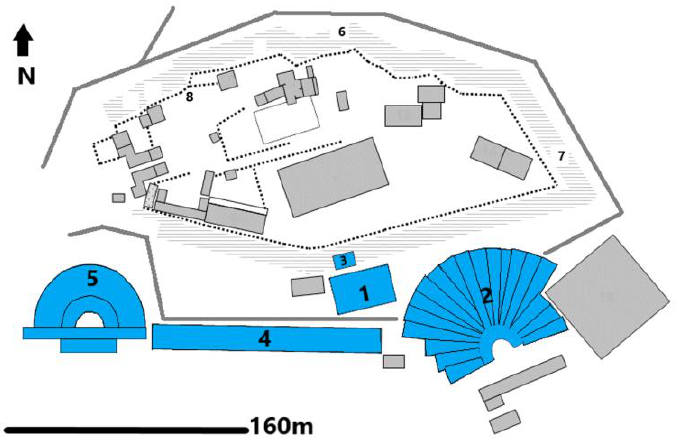
Figure 7. Plan of the Acropolis hill, showing the locations of the studied geotopes: 1 . GS1 Ascleipieion, 2 . GS2 Theater of Dionysus, 3 . GS3 The Choragic Monument of Thrasyllos, 4 . GS4. Stoa of Eumenes, 5 . GS5 Odeon of Herodes Atticus—Herodeion. 6 . GS6 Caves, 7 . GS7 Klepsydra, 8 . GS8 Mycenaean Fountain.